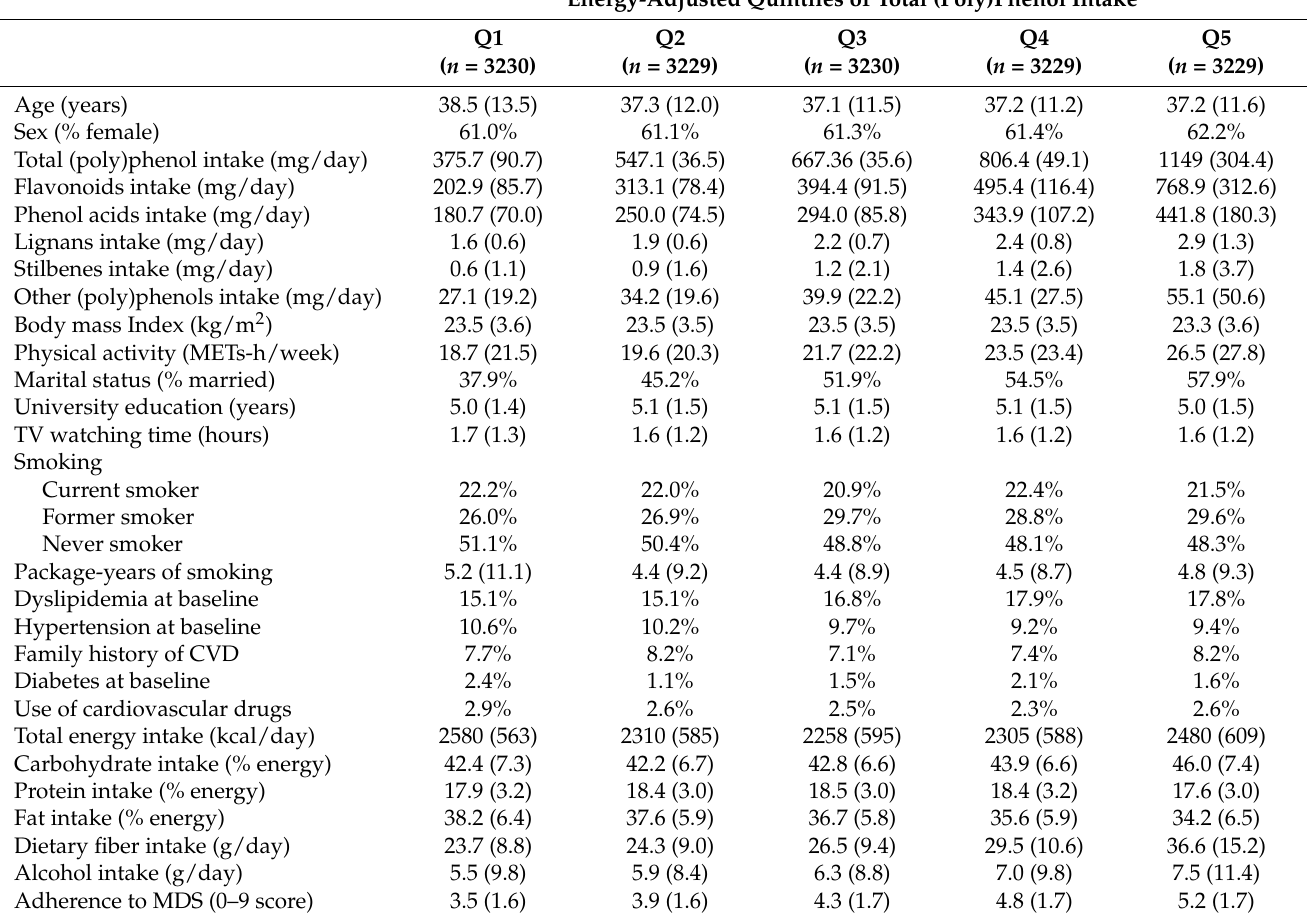
Table 1. Baseline characteristics * of participants across sex-specific energy-adjusted quintiles of total (poly)phenol dietary